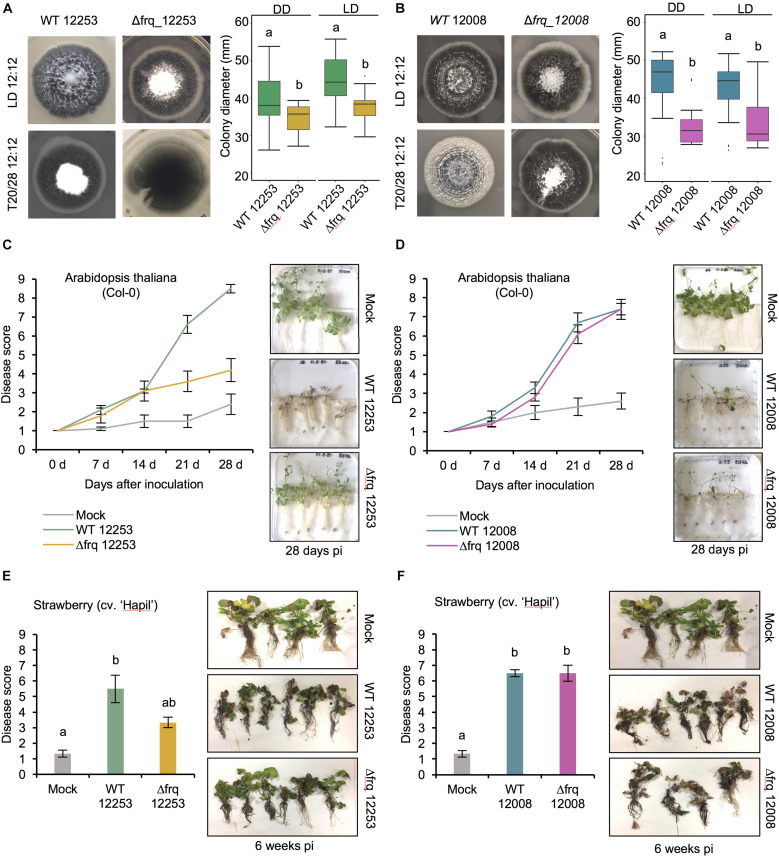
The effect of Vdfrq deletion mutants on fungal growth and pathogenicity. (A) Phenotype of V. dahliae frq deletion in 12253 and (B) 12008 background. PYLA plates point inoculated with WT 12253, Δfrq_12253, WT 12008 and Δfrq_12008 and incubated in LD 12:12 and temperature (20/28) 12:12 cycles for 14 days. Boxplot graphs depict WT 12253, Δfrq_12253, WT 12008 and Δfrq_12008 colony diameters in DD and LD, n = 6. Letters indicate statistical differences (p-value < 0.05), Tukey’s HSD test. (C) Disease score of A. thaliana in vitro seedlings inoculated with V. dahliae isolates WT_12253 or Δfrq_12253 at 0, 7, 14, 21, and 28 days post-inoculation under 12:12 LD cycle. The area under the disease progression curve (AUDPC) was calculated. Different letters indicate statistical differences (p-value < 0.05), Tukey’s HSD test. Disease symptoms 28 days after inoculation of A. thaliana seedlings with V. dahliae isolates and a mock (control) inoculation are shown on the right. (D) Disease score of A. thaliana in vitro seedlings inoculated with V. dahliae isolates WT_12008 or Δfrq_12008.
(E) Disease score of the susceptible strawberry cultivar Hapil inoculated with WT_12253 and Δfrq_12253, 6 weeks after inoculation. A one-way ANOVA was performed. Data are presented as mean (±SEM) with different letters indicating statistical differences (p-value < 0.05). Disease symptoms 6 weeks after inoculation of strawberry plantlets with V. dahliae isolates and a mock (control) inoculation are shown on the right. (F) Disease score of the susceptible strawberry cultivar Hapil inoculated with WT 12008 and Δfrq_12008. The same mock picture is shown in (D) and (F) as these plants served as controls in an experiment in which plants were inoculated with either sterile water (mock), 12253 or 12008 isolates.